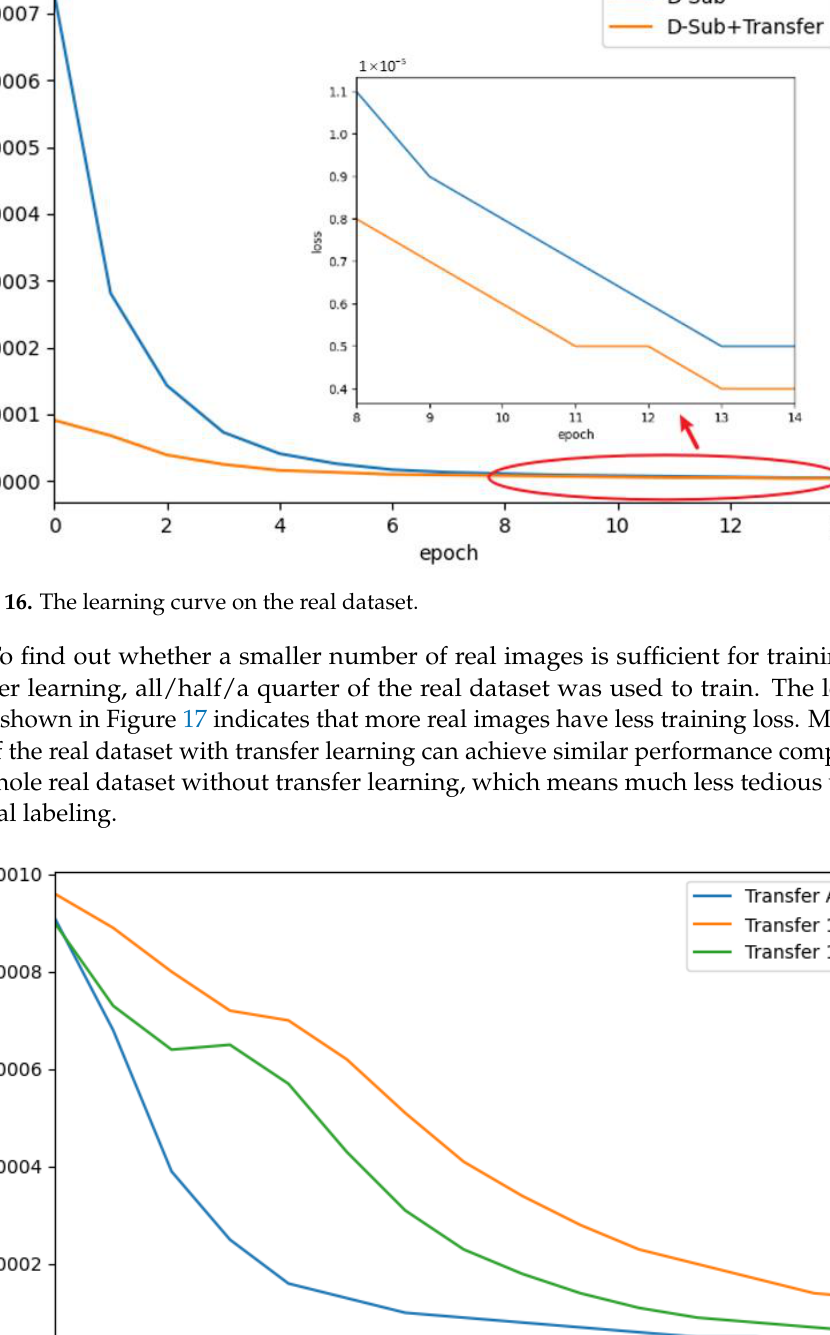
Figure 17. The learning curve on all/half/a quarter of the real dataset with transfer learning.